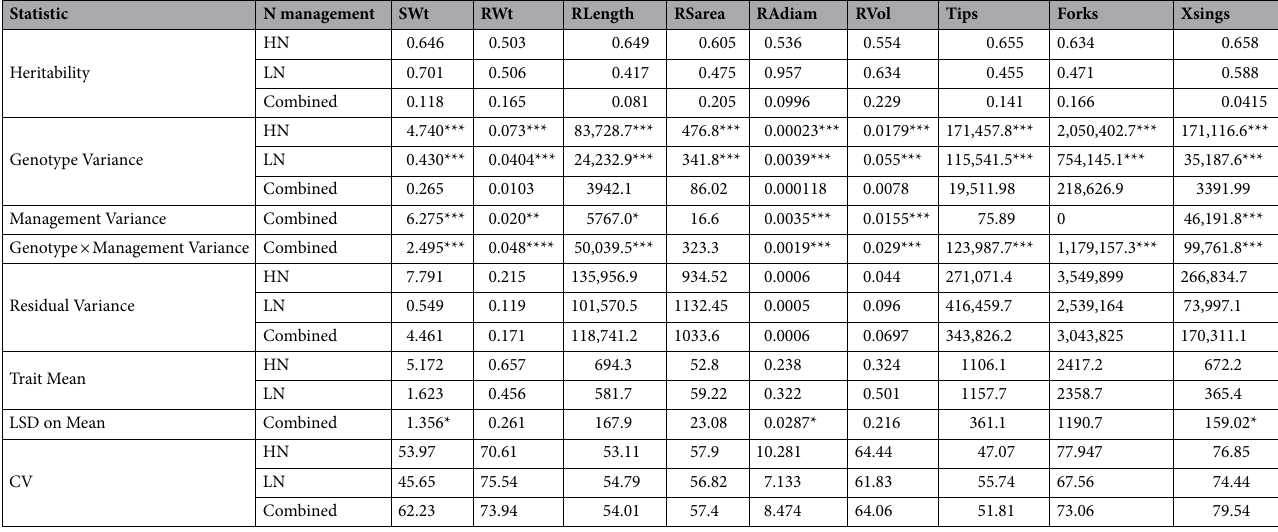
Table 5. Variance, heritability and means separation for shoot weight and root traits. LN, low N; HN, high N; LSD, least significant difference; CV, coefficient of variations; *, **, ***significant at p = 0.05, 0.05 > p ≥ 0.01, p < 0.01,